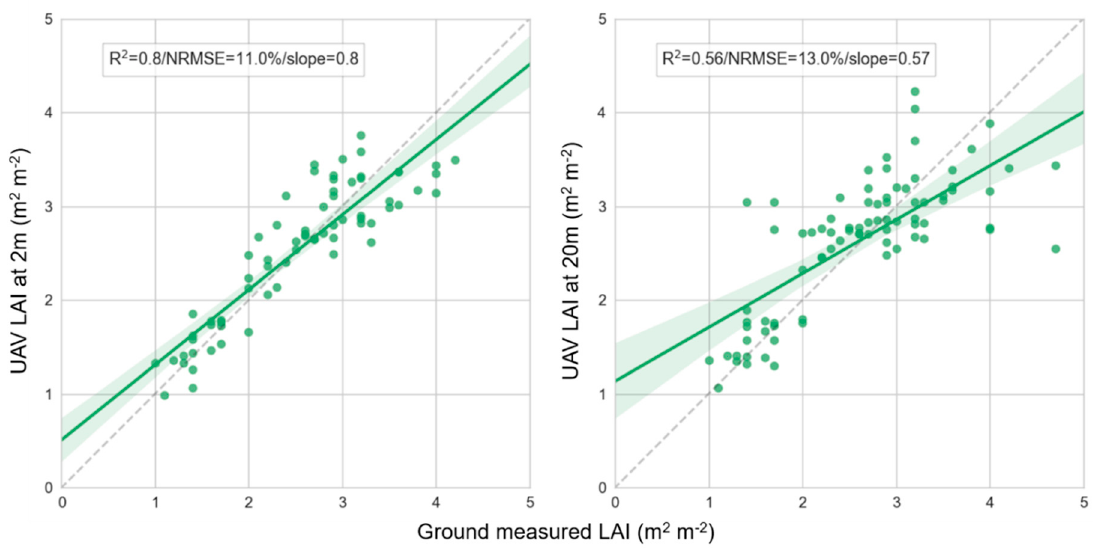
Figure 5. Scatter plot comparisons between LAI retrieval models calibrated with UAV multispectral data aggregated at 2 m ( left ) and aggregated to a 20 × 20 m square grid cell ( right ). Both calibration approaches are compared to LAI ground measurements acquired at 80 locations. Plot includes a liner fit line (solid green line) with 68% confidence interval (shaded green area). The dashed gray line represents the 1:1 line.